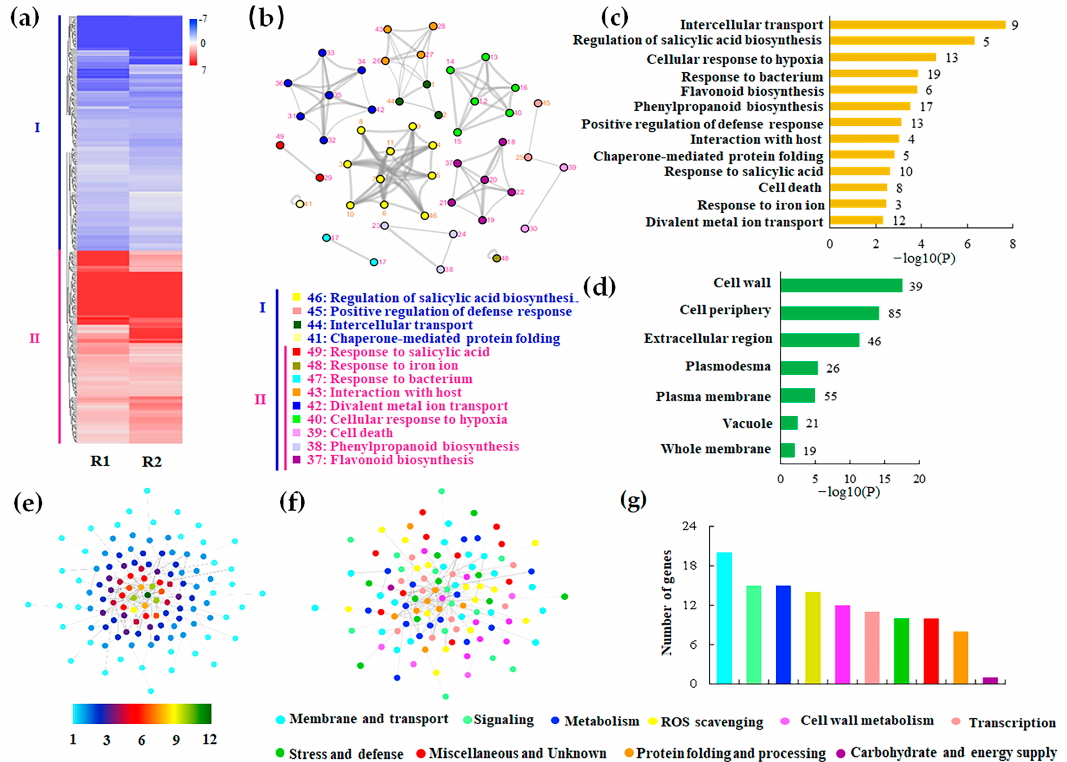
Figure 5. Cluster analysis and enrichment of differential expression genes (DEGs) and the predicted interaction networks of their encoding proteins in socsld2 mutants. (a) Hierarchical clustering analysis of DEGs. Two columns represent two replications of fold change of DEGs in socsld2 mutant (R1, R2). The rows represent individual genes. The increased or decreased genes are indicated in red or blue, respectively. The detailed information is listed in Supplemental Table S3. (b) Network of enriched terms of GO biological processes and KEGG pathways across the DEG lists of the two clusters. Each node represents an enriched term. The term genes next to the nodes are shown in Supplemental Table S4. The terms with a similarity > 0.3 are connected by edges. The same color nodes represent a subset of enriched terms, where the terms with the best p-values are highlighted with bold words. The color of the term genes (i.e., blue and pink) correspond to Cluster I and Cluster II, respectively. (c) Bar graph showing the summary of subsets enriched according to GO biological processes and KEGG pathways. The number in right represents number of DEGs enriched in each subset. (d) Enrichment analysis for cellular components of DEGs by GO annotation. The number on right represents number of DEGs enriched in each term. (e,f) Predicted interaction networks of proteins encoding by DEGs. Proteins (nodes) are shown as bubbles filled with different colors. The related interactions (edges) between proteins are shown as gray lines. (e) Heatmaps representing the node degree of each protein in the interaction network, respectively. The range of degree distribution is shown as a color gradient from light blue to dark green. (f) Proteins encoding by DEGs in various function categories, which are indicated by the node fill color. (g) Numbers of proteins encoding by DEGs in different function